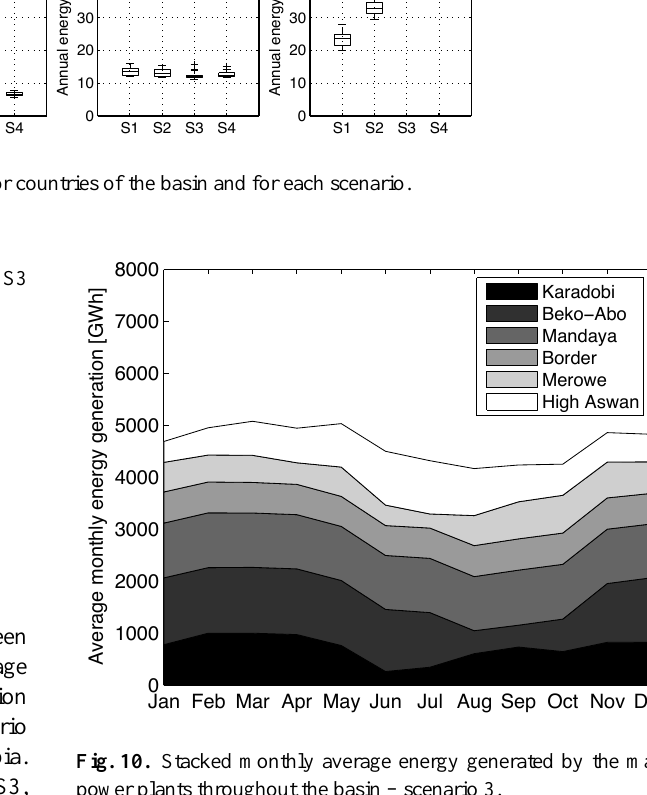
Figure 11 analyzes the temporal distribution of the